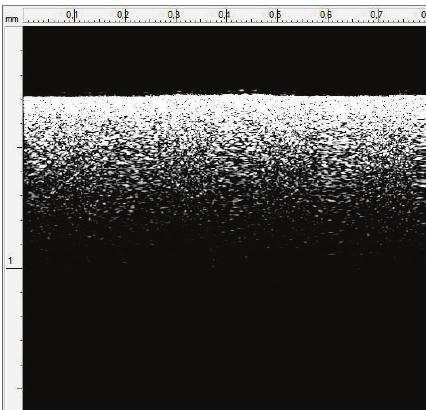
Figure2:AtypicalOCTscanimage.Thebrighterregionsarisefrom the reflected light due to the refractive index mismatch between air andeggshell.Thescanlengthis0.8 mmandthescandepthis1.6 mm.